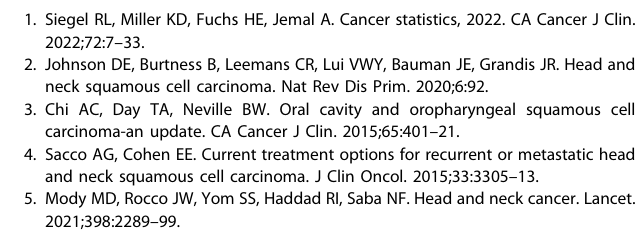
Fig. 8 A proposed model of TAZ deubiquitination and stabiliza- tion by USP7 in HNSCC. TAZ protein is under tight control by USP7 and β -TRCP through ubiquitination and deubiquitination processes. Upon TAZ translocates into nucleus, USP7 interacts with, deubiqui- tinates and stabilizes TAZ as well as facilitates its nuclear retention to activate transcription of downstream targets to drive HNSCC